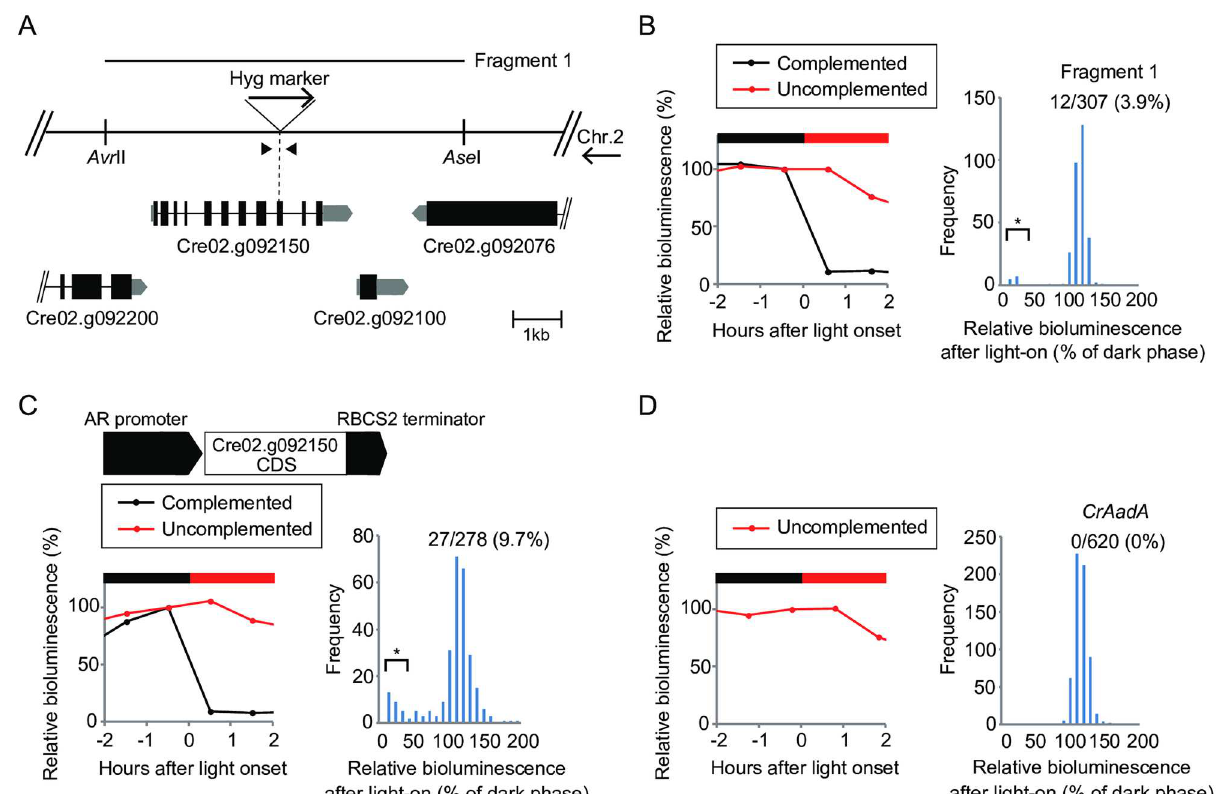
Fig 6. Identification of the disrupted gene in b16 . (A) Schematic representation of genomicregionaroundthe insertionsite (shown in reverse orientationof the sequencefor chromosome2). The specific primers bracketingthe insertion site are shown as arrowheads. (B – D) , Complementation of the b16 phenotype. b16 mutant was transformed with a gDNA fragment (B, Fragment 1) and cDNA of the Cre02. g092150gene (C). The left panels show ROC15-LUC bioluminescence of representative transformants monitoredunder the same conditionsas Fig 1. Data before and after the light onset of the first DL cycle are shown. The bioluminescence level just before light onset was set to 100. The right panels are histograms representing the distributionof bioluminescence levels of all transformants after light on (relative to the dark phase). Asterisks indicatecomplementedtransformants (the relative bioluminescence level after light on < 30). Numbers of complemented transformants and the rate of complementation are indicatedin the graphs. A negativecontrol experiment where b16 mutant cells were transformed by CrAadA marker only is shown